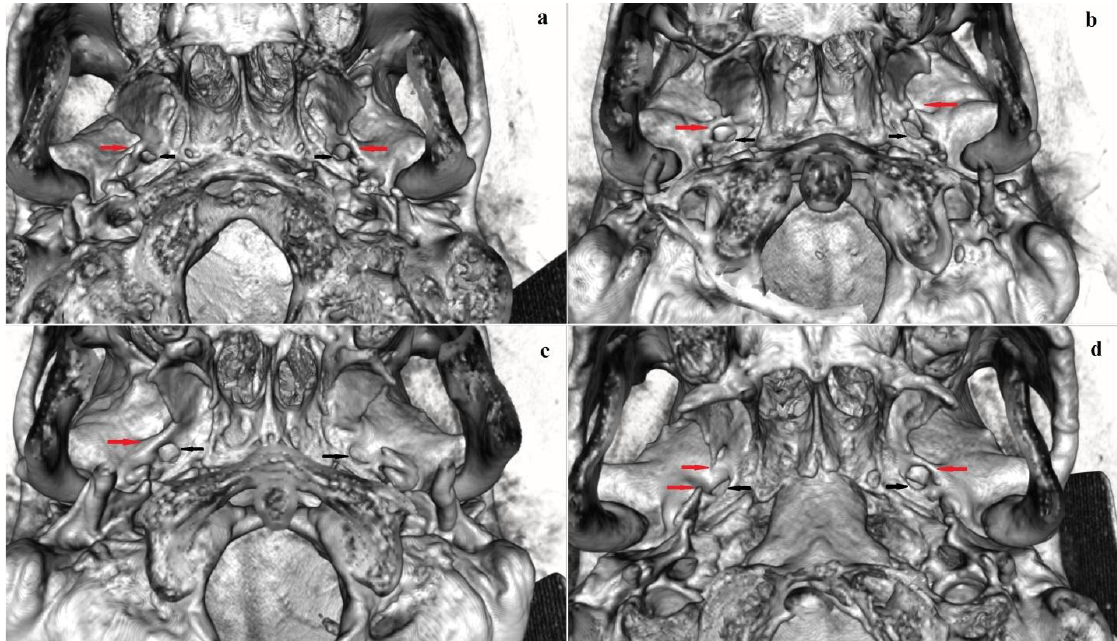
Figure 3. Pterygoalar bridge: ( a ) a bilateral complete PaB, enclosing PaF; ( b ) a complete PaB on the right side and an in complete PaB on the left side; ( c ) a unilateral (right - sided) complete PaB; ( d ) an incomplete PsB on the right side and a complete PaB on the left side. Designations: red arrows point to PsBs; black arrows point to foramen ovale. Abbreviation: PaB—pterygoalar bridge, PaF—pterygoalar foramen, PsB—pterygospinous bridge.